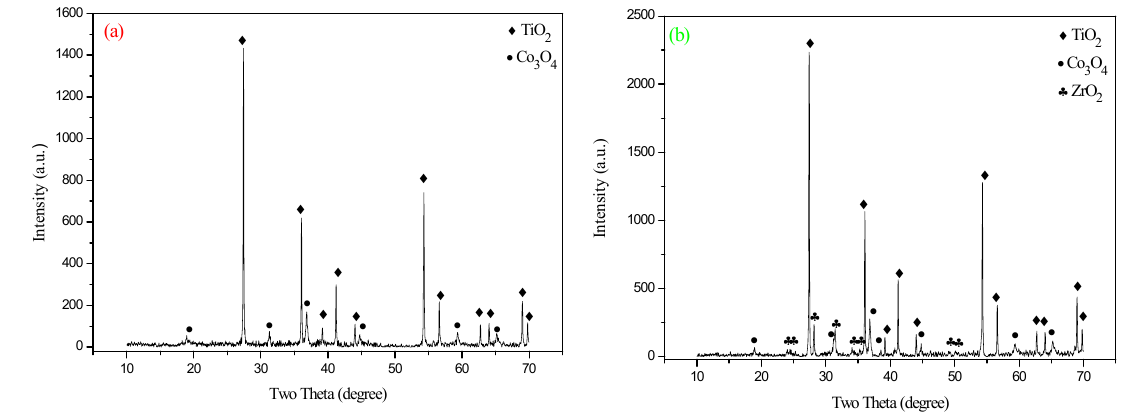
Figure 1. XRD patterns of catalysts ( a ) Co 3 O 4 /TiO 2 ( b ) 8% wt. ZrO 2 ‐ Co 3 O 4 /TiO 2 .